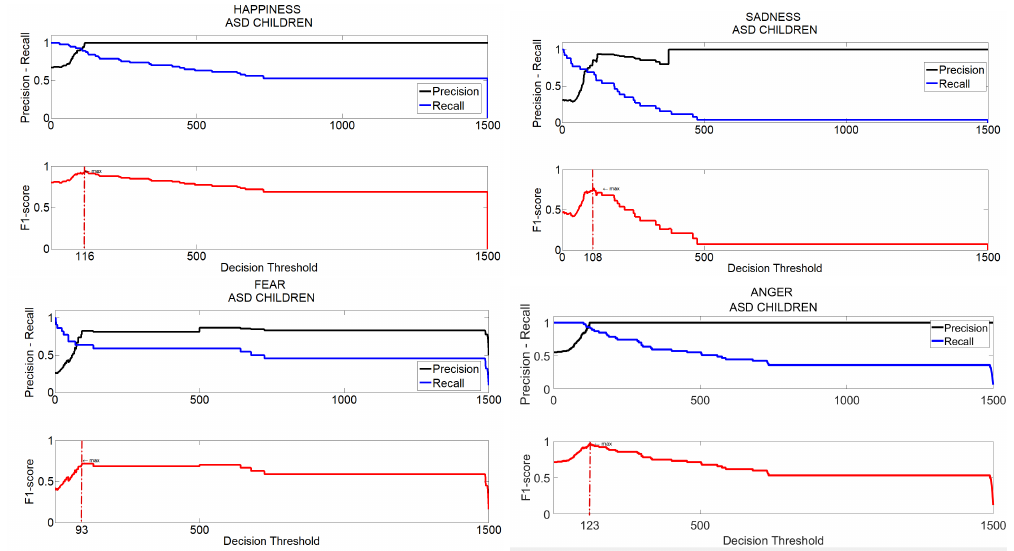
Figure 12. Expressions by ASD children: Classification accordance between system and experts while varying decision